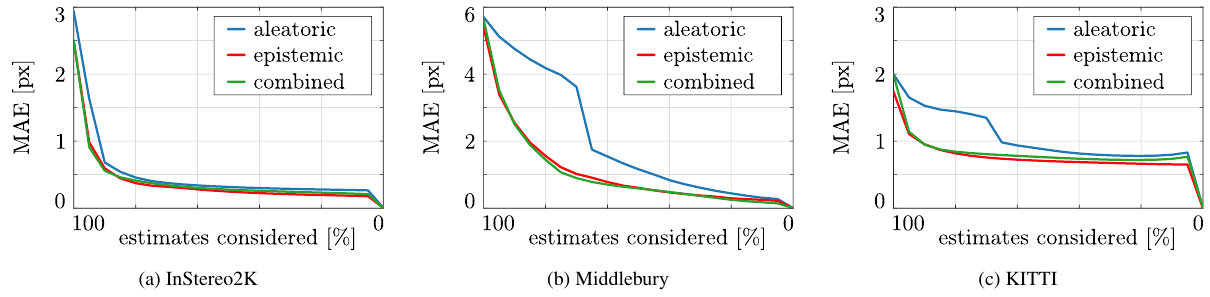
Figure 2. Sparsification plots with respect to the different types of uncertainties estimated. The figures show the mean absolute disparity error considering all test images of the respective dataset on the y-axis and the percentage of considered disparity estimates on the x-axis. The percentage is reduced discarding pixels that have assigned the highest uncertainties first. The depicted curves correspond to the aleatoric, epistemic and combined uncertainty predicted with the variants deterministic + CVA-Net , probabilistic and probabilistic + CVA-Net ,